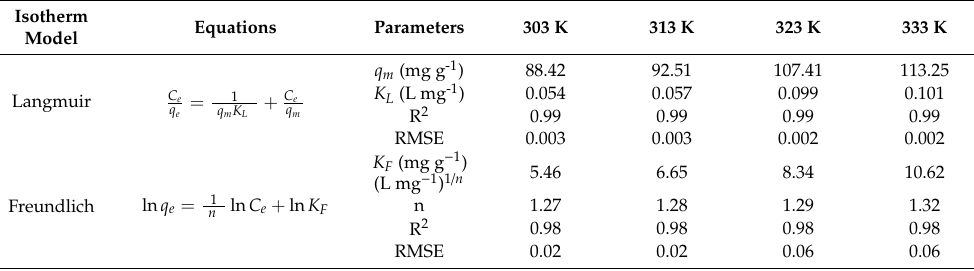
q m (maximum adsorption capacity), K L (Langmuir constant), R 2 (regression coefficient), RMSE (root mean square error), K F (Freundlich adsorption capacity), n (Freundlich constant for favorability). Figure 7d and Table 3 constitute the thermodynamic plot and corresponding calculated parameters obtained through adsorption experiment conducted for 60 mg L −1 CV in temperature range of 303–333 K. − 1 Based on Equations (8)–(10), a value of enthalpy ( ∆ H) as 3.62 KJ mol with positive